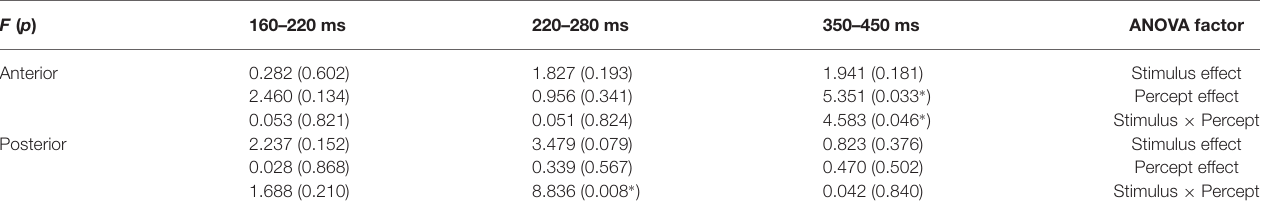
*Indicates significance at the 0.05